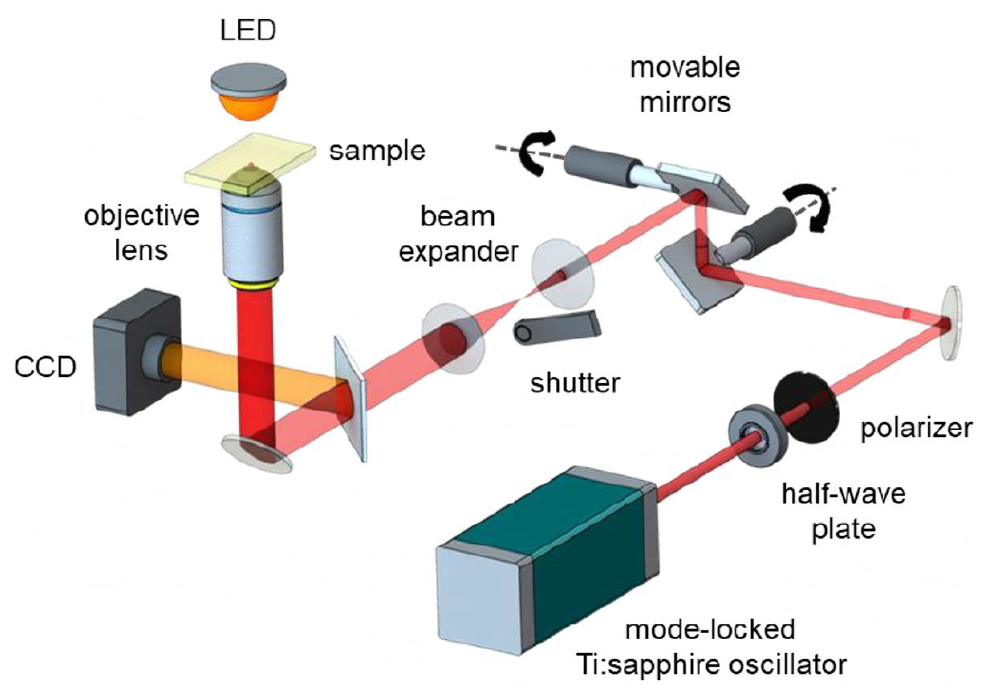
Figure 5. Representation of the femtosecond laser microfabrication via TPP setup, showing the basic components of the system. Reprinted with permission [40]. Licensed under a Creative Commons Attribution 4.0 International license.